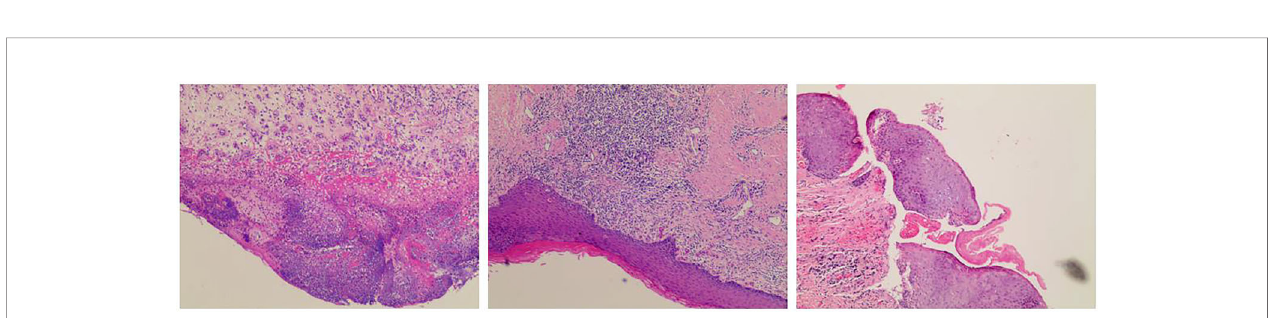
FIGURE 4 | Postoperative pathological. Pathological examination revealed a vulva low-grade squamous intraepithelial lesion (LSIL) with negative margin, no residual cancer was found.